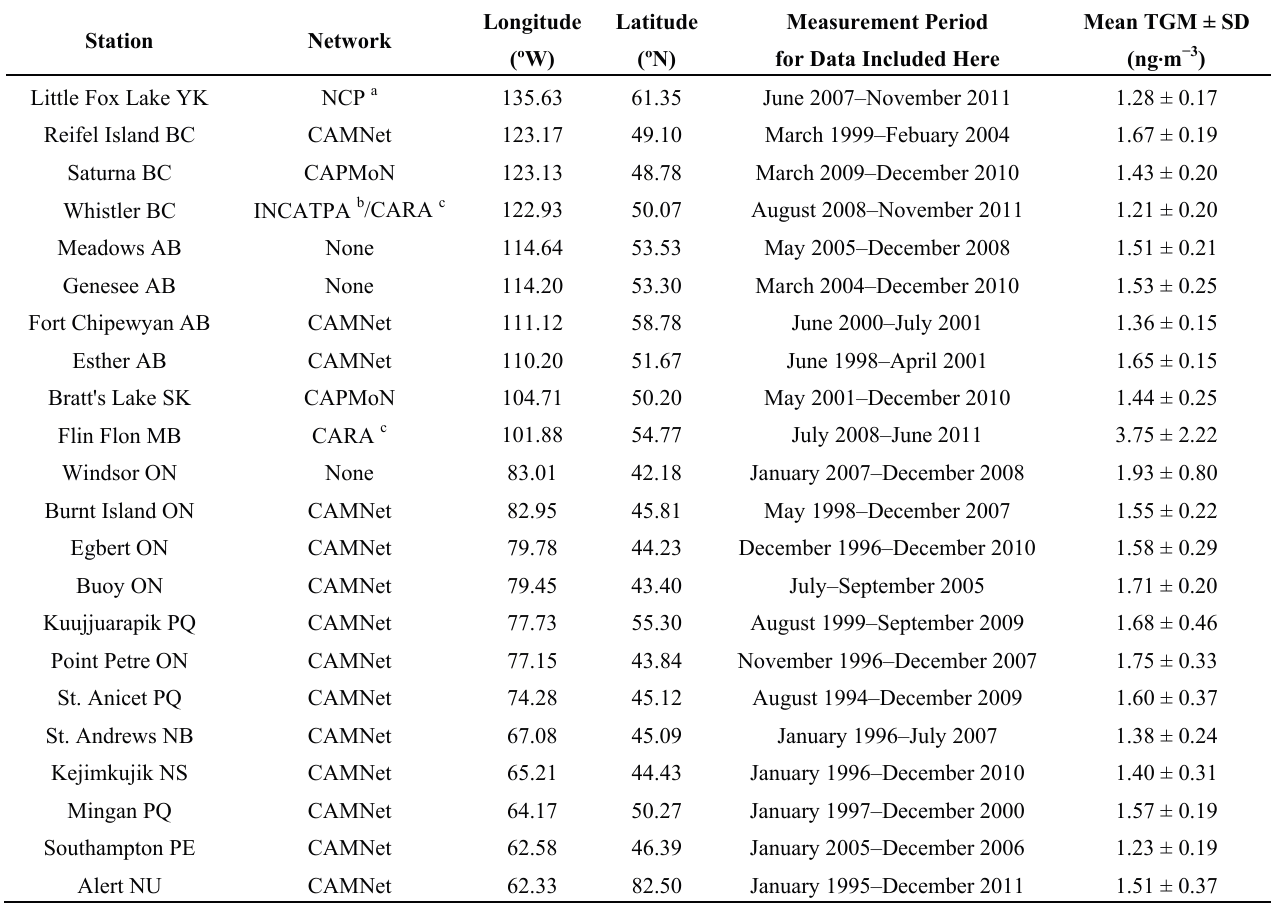
Table 1. Stations measuring total gaseous mercury (TGM) in Canada and mean daily concentrations over the entire measurement